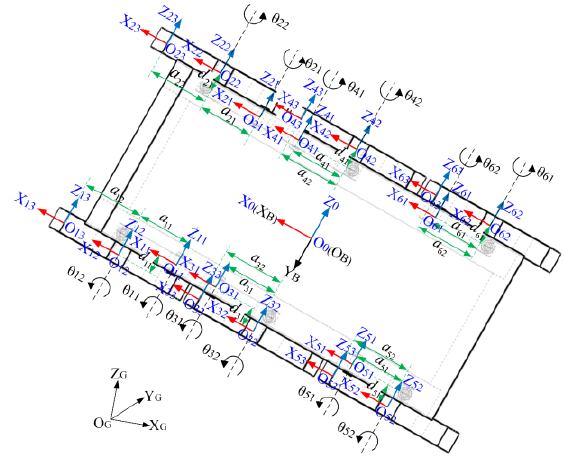
Figure 1. Mechanical structure of the six-track robot. Table 1. Nominal parameters of six-track robot.